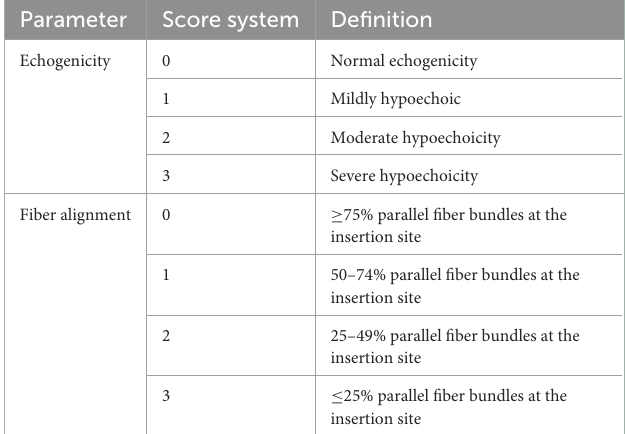
TABLE 2 Ultrasound assessment system